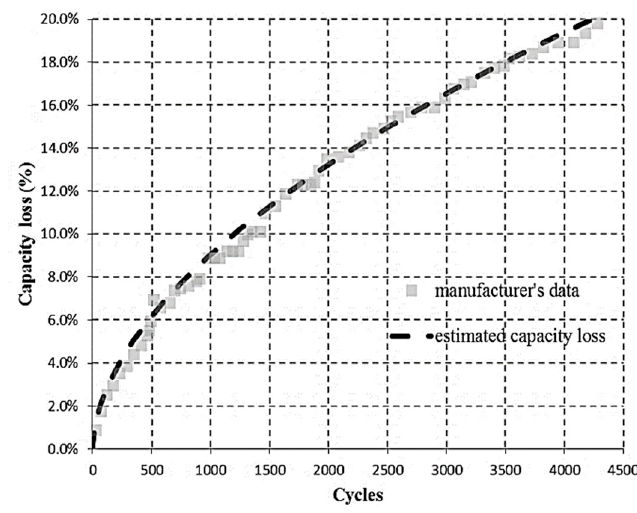
Figure 7. Experimental values [21] and fitting curve of B coefficient in the battery model (4), vs. C-rate .